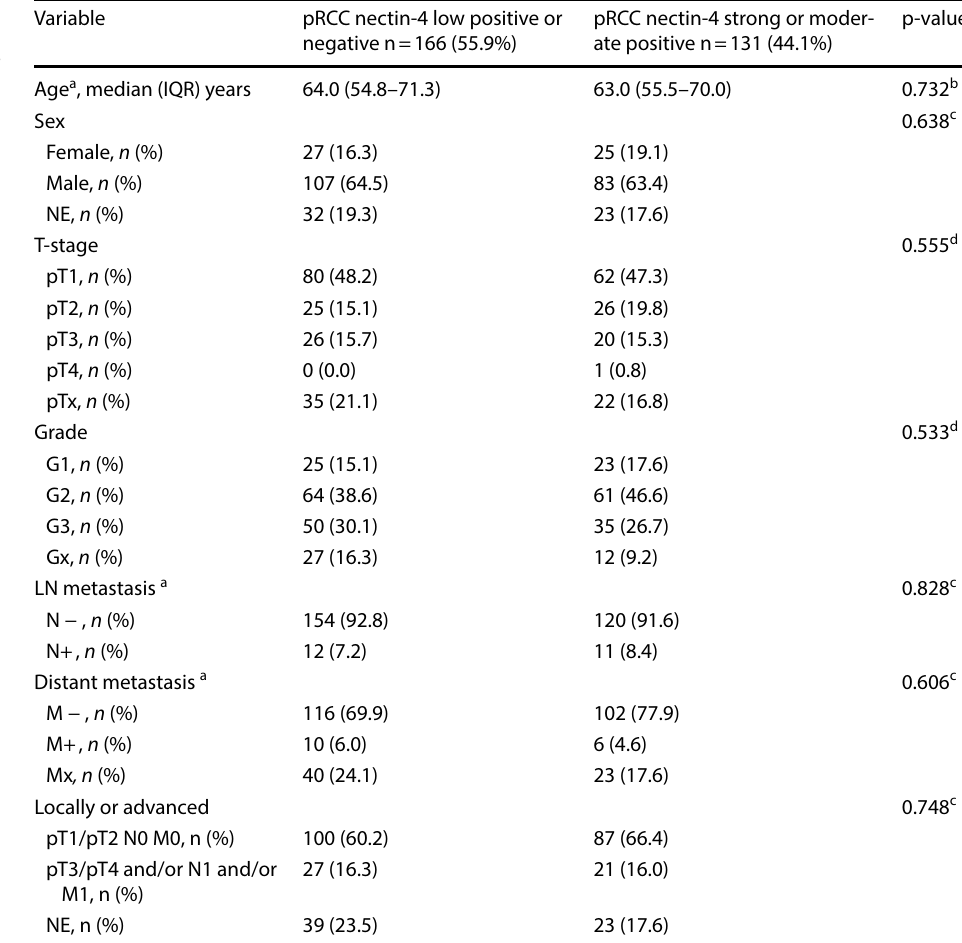
Table 2 Characteristics of patients with papillary renal cell carcinoma in dependence of Nectin-4